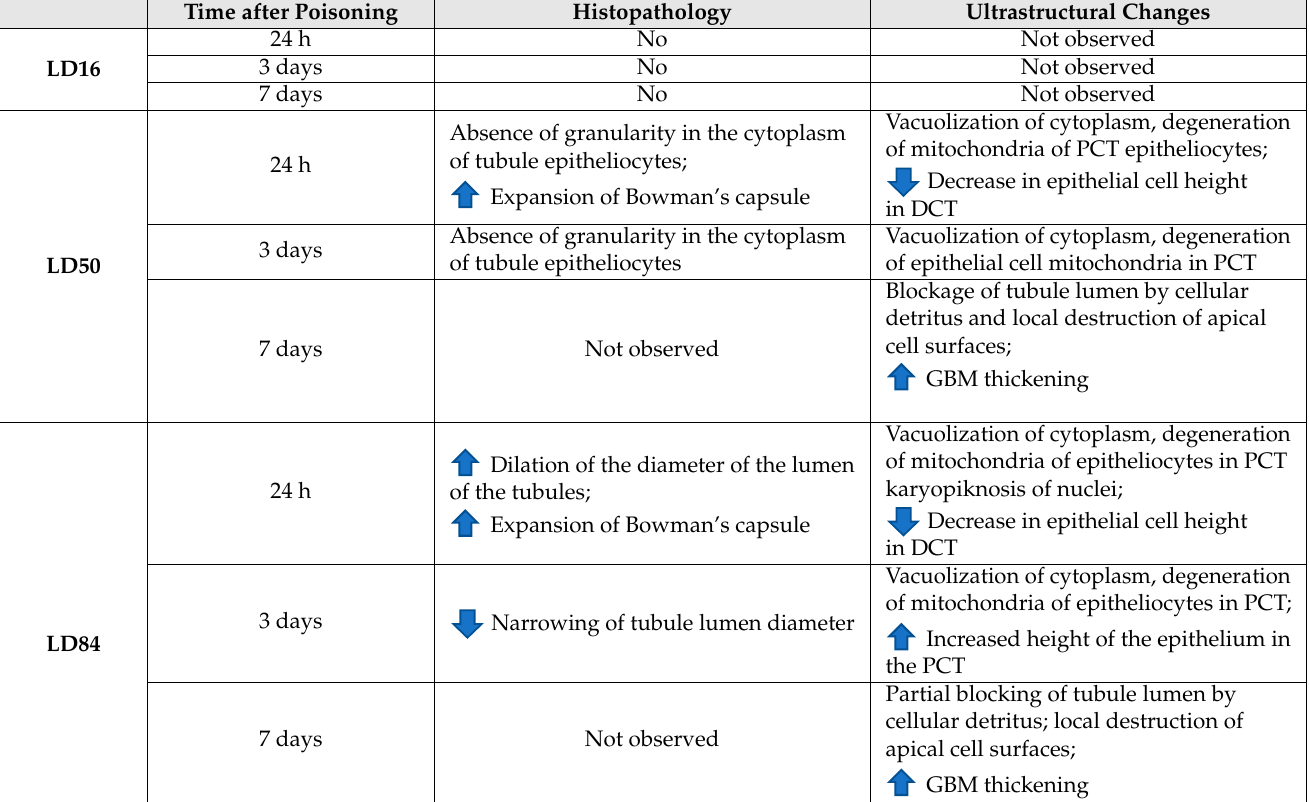
Table 3. Signs of POX nephrotoxicity in the M3 model.